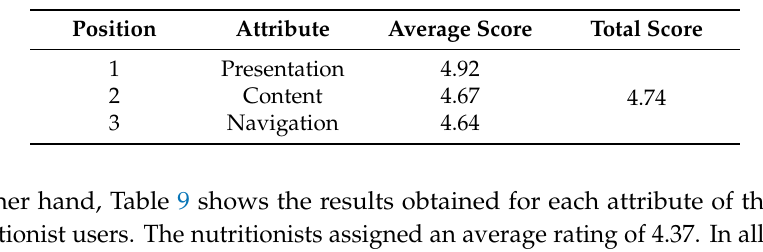
Table 8. Results of Instrument 3, physician profile.